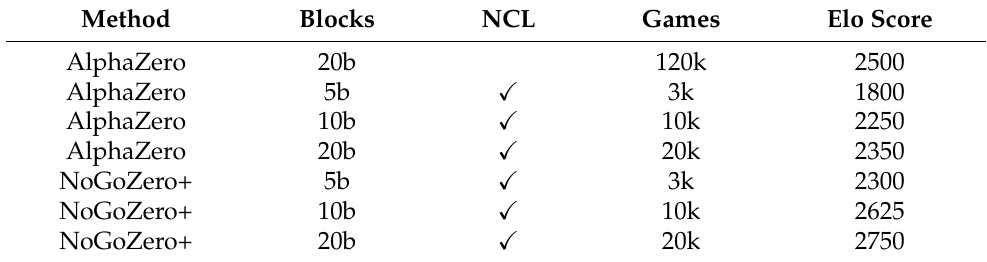
Table 1. Comparison of Elo ratings among original AlphaZero, AlphaZero with only network cur- riculum learning, and complete NoGoZero+. NCL, network curriculum learning. NoGoZero+ had advantages over the original AlphaZero in final performance (Elo rating) and training speed. More- over, the obvious gap between complete NoGoZero+ and AlphaZero with only network curriculum learning indicated the supplementary power of other techniques. Blocks represent the number of residual blocks in the